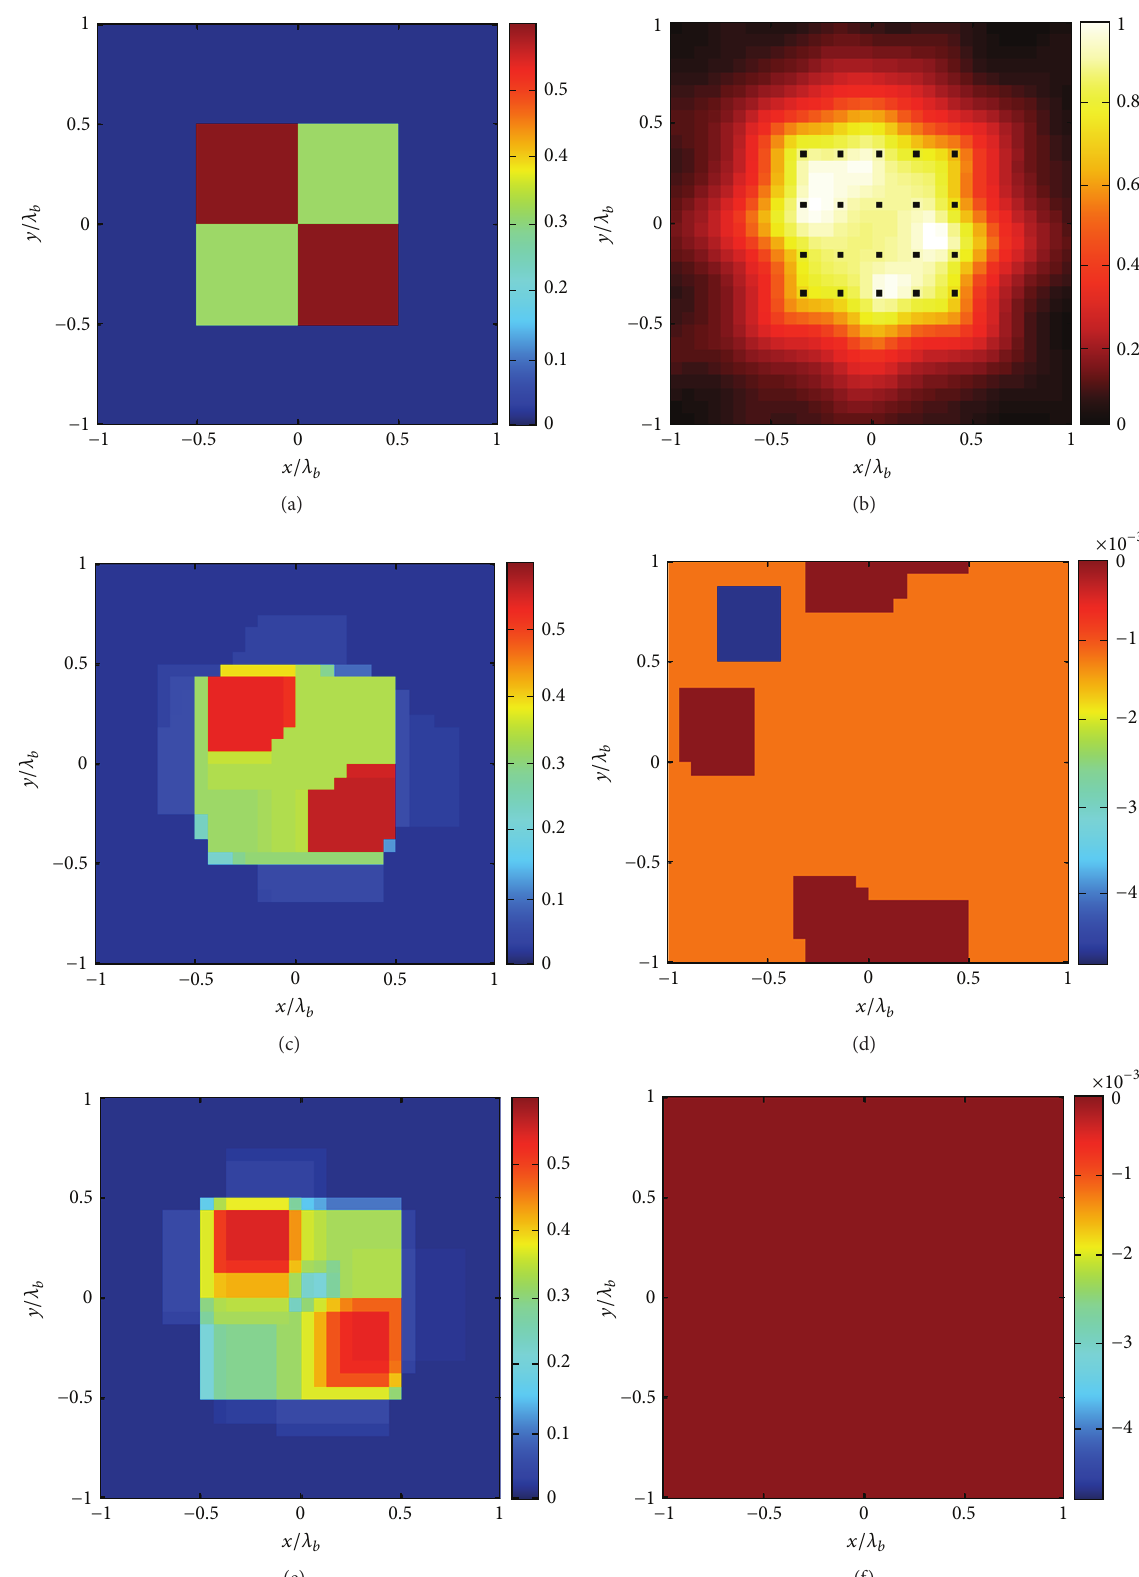
Figure 3: The inhomogeneous square example. (a) Real part of the contrast reference profile. (b) Normalized logarithmic LSM indicator with the selected pivot points superimposed as dots. The retrieved profile by means of the approach (4) ( 𝛿 = 0.32‖ b ‖ ℓ (d) imaginary part. The retrieved profile by means of the approach (6) ( 𝛿 = 0.32‖ b ‖ ℓ